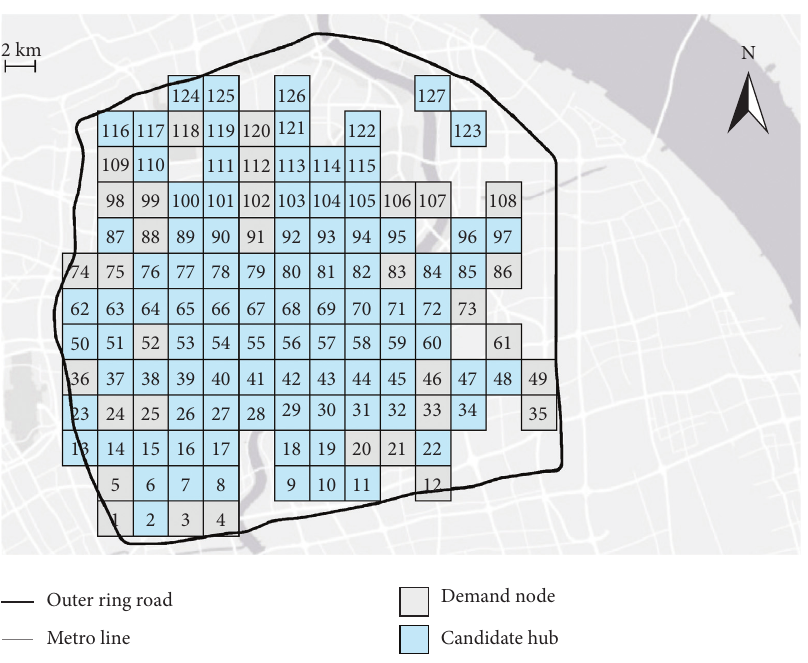
Figure 2: The study area of Shanghai, China (source: authors’ revision based on OpenStreetMap).